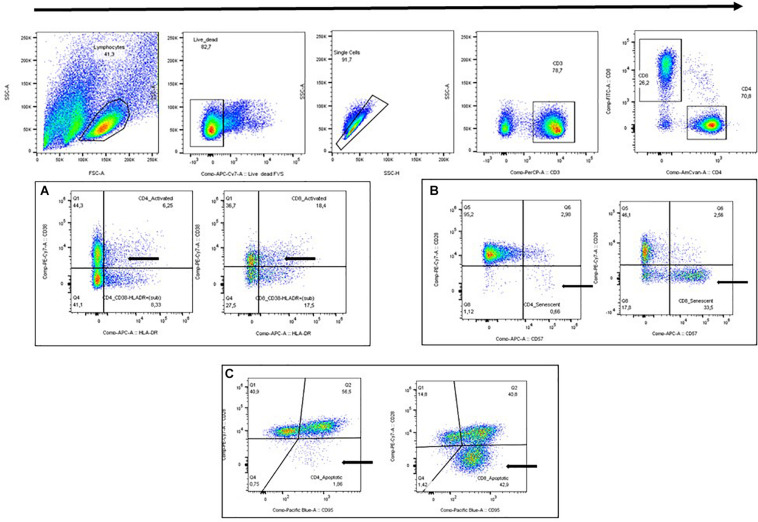
Gating strategy. (A) Activated T-cells (HLA-DR+ CD38+). (B) Senescent T-cells (CD28-CD57+). (C) Apoptotic T-cells (CD28-CD95+).